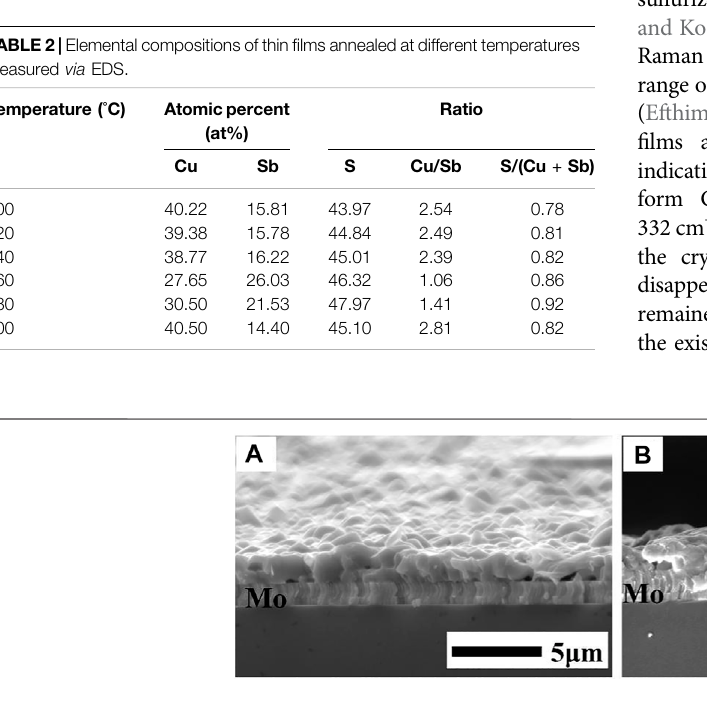
FIGURE 7 | Cross-sectional SEM images of CuSbS 2 thin fi lms annealed at (A) 360 ° C and (B) 380 ° C.